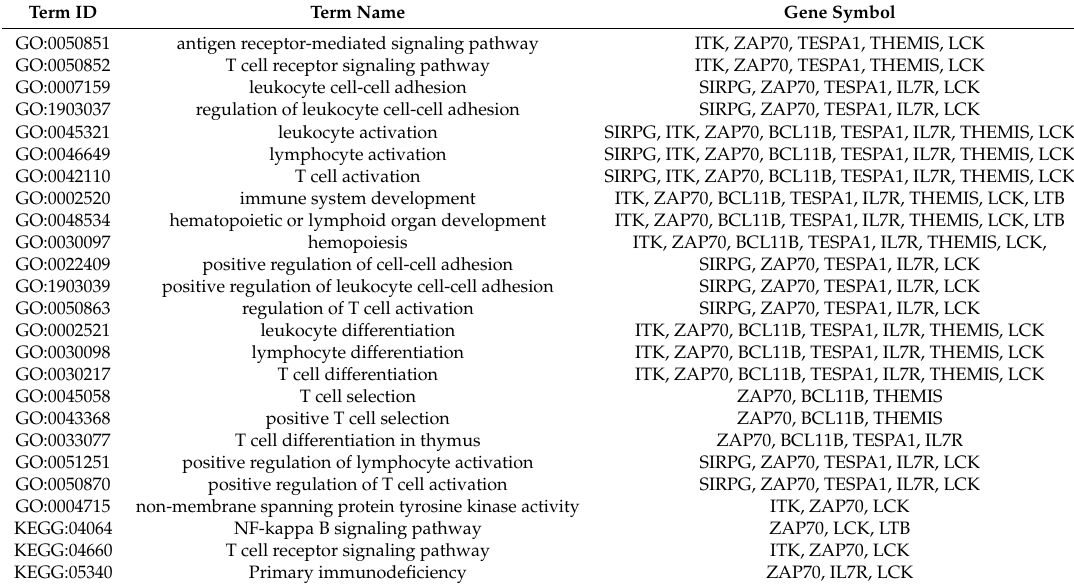
Table 3. Gene Ontology (GO) and Kyoto Encyclopedia of Genes and Genomes (KEGG) analysis of differentially-expressed genes identified in IUGR-affected